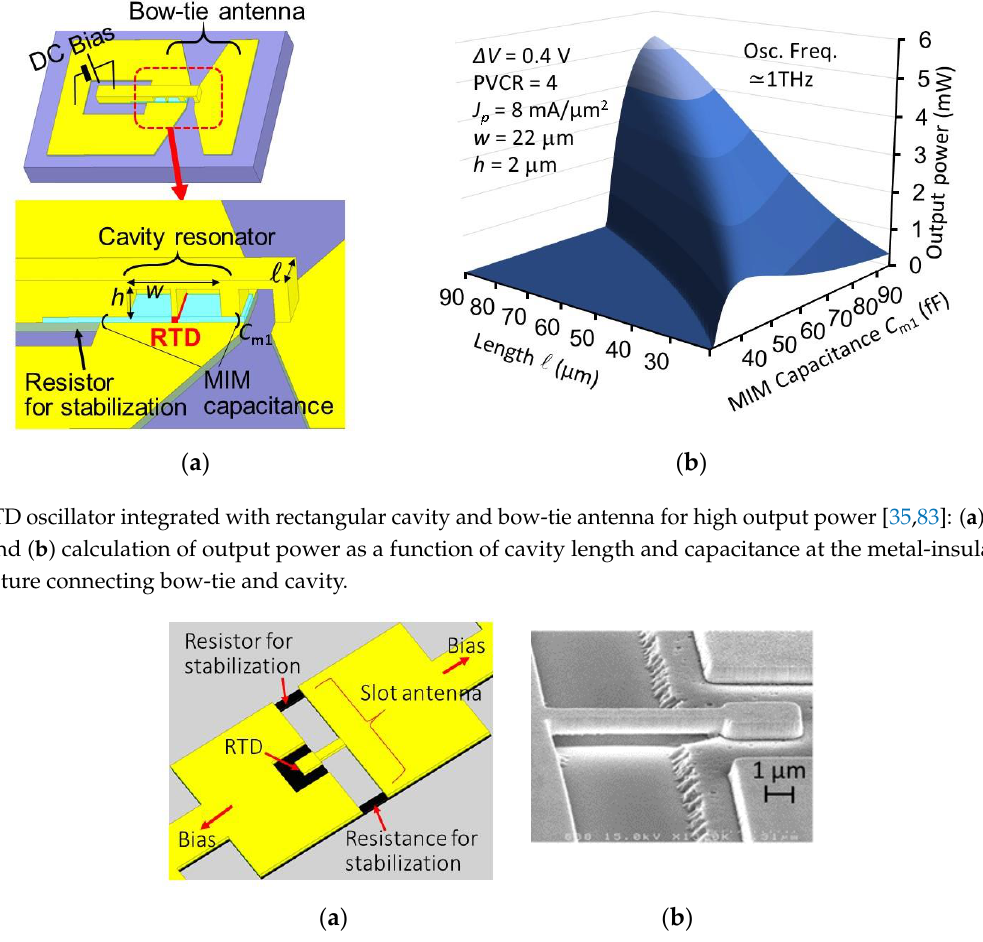
Figure 8. Simplified structure of RTD oscillator integrated with slot antenna. RTD oscillator ( a ) sim- plified steucture of RTD oscilator integrated with slot antenna; ( b ) SEM image of the fabricated airbridge. Reprinted with permission from Reference [84]. Copyright (2020) Springer